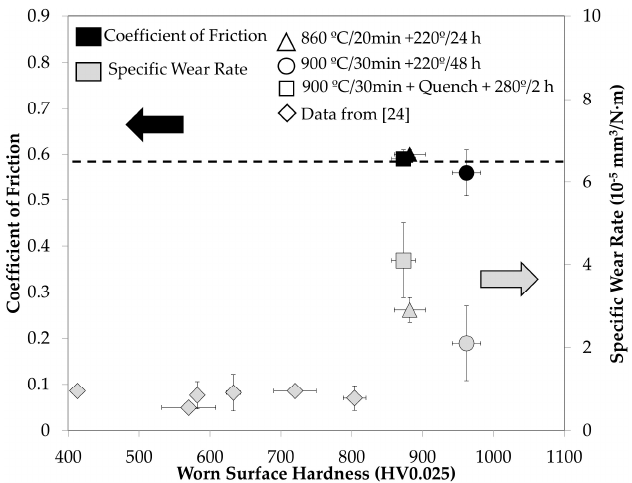
Figure 6. Coefficient of friction (black points) and specific wear rate (grey points) as a function of the worn surface hardness of bainitic structures formed at 220 °C after austenitization at 860 °C for 20 min (circles) and 900 °C for 30 min (triangles); martensitic structures formed after austenitization at 900 °C for 30 min, quenching, and tempering at 280 °C for 2 h (squares) in Nanobain bearing steel; and bainitic and tempered martensitic structures obtained in a 1C-2.3Si, as reported elsewhere [24].